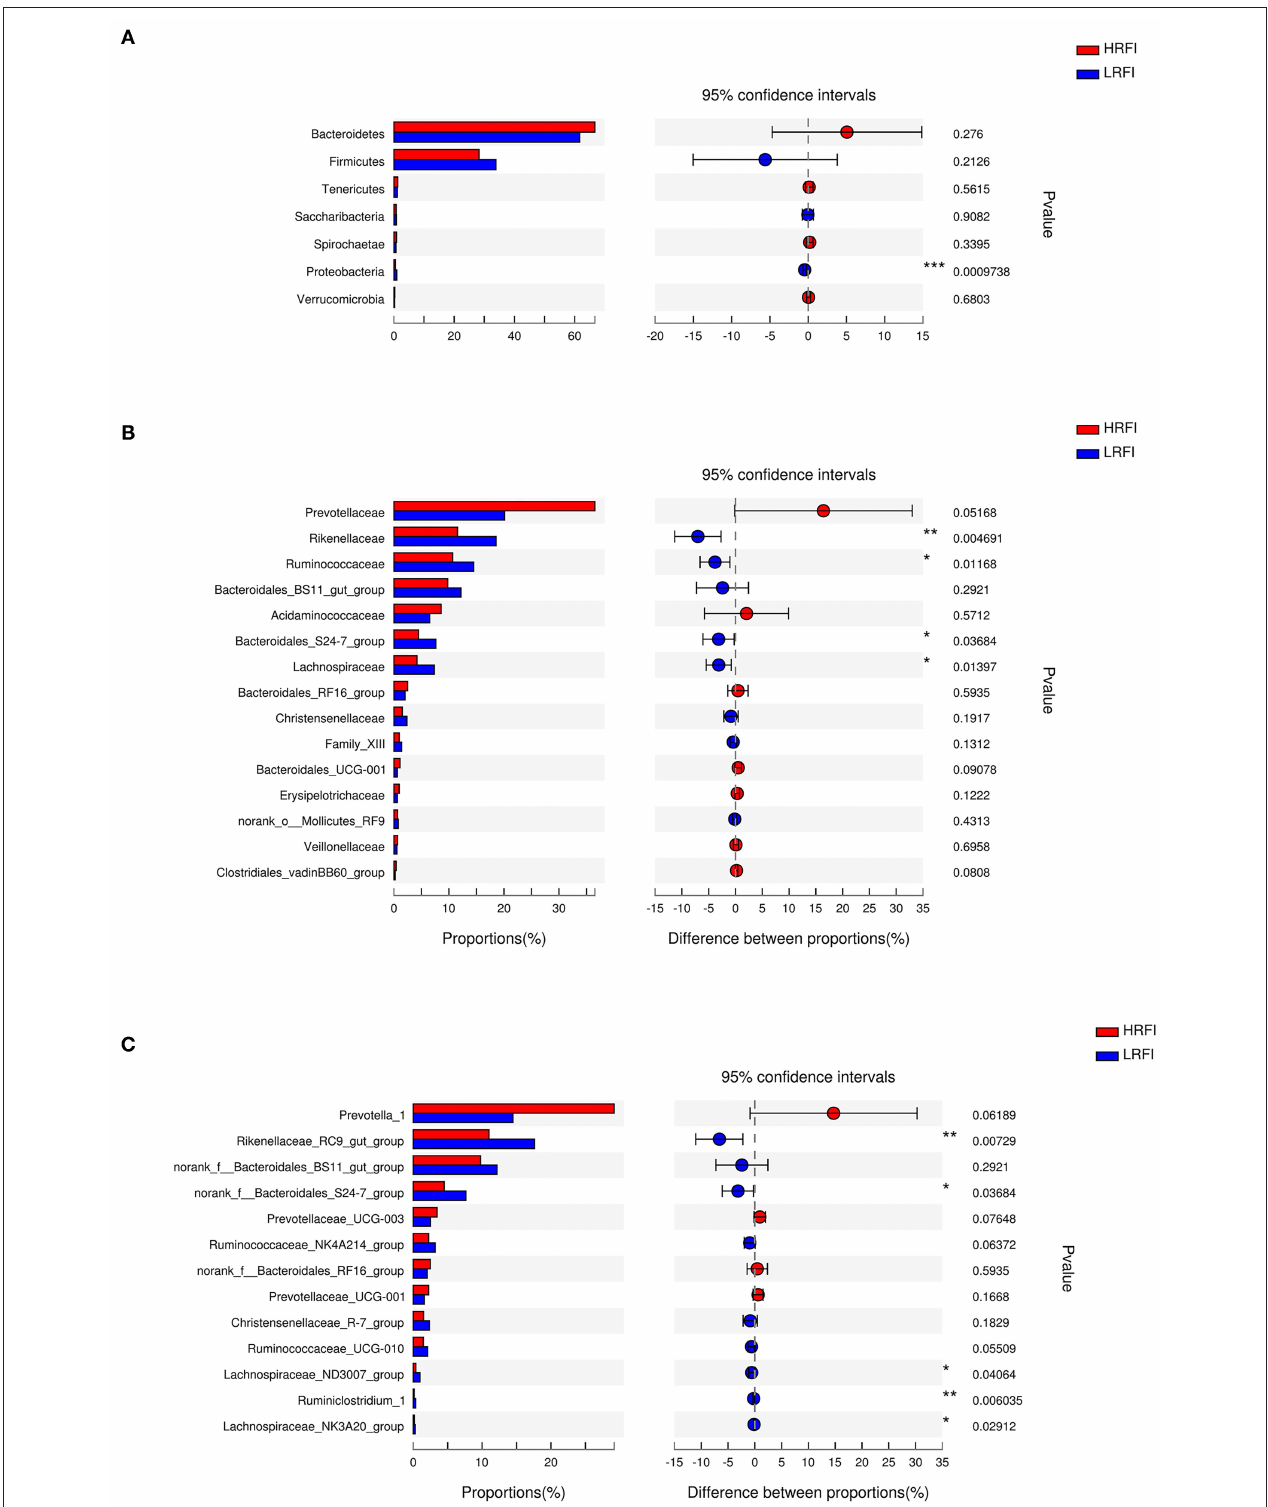
FIGURE 2 | Classification of the ruminal bacterial community composition across the HRFI and LRFI groups. Extended error bar plot showing the significantly different phyla (A) , families (B) , and genera (C) (relative abundance > 0.1% for all samples). Positive and negative differences indicate a greater abundance in the HRFI group and LRFI group, respectively. Asterisks indicate significant difference between the HRFI and LRFI groups (*** P ≤ 0.001, **0.001 < P ≤ 0.01; *0.01 < P ≤ 0.05).